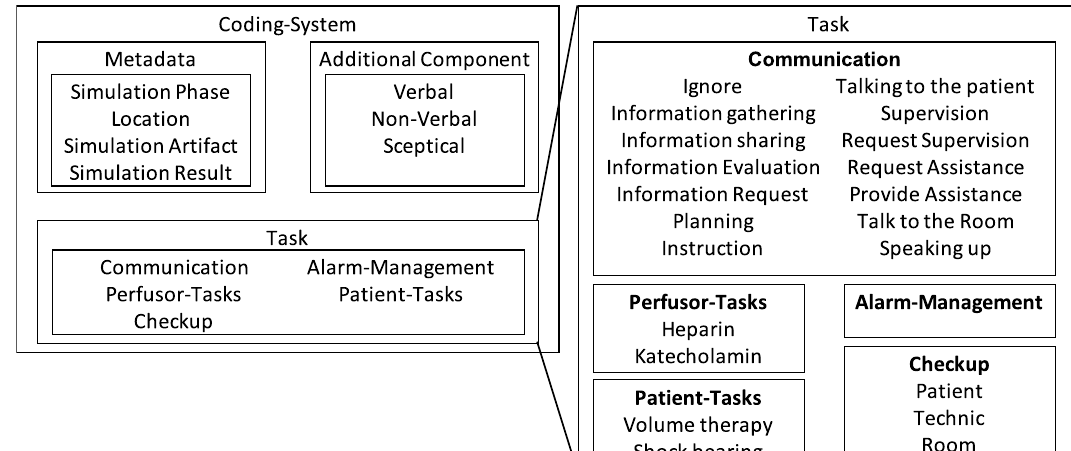
Figure 3. This figure presents the used coding scheme. We modified the established code system of Kolbe et al. 33 and Burgoon et al. 43 to cover verbal and non-verbal expressions and combined it with the most prominent tasks of our